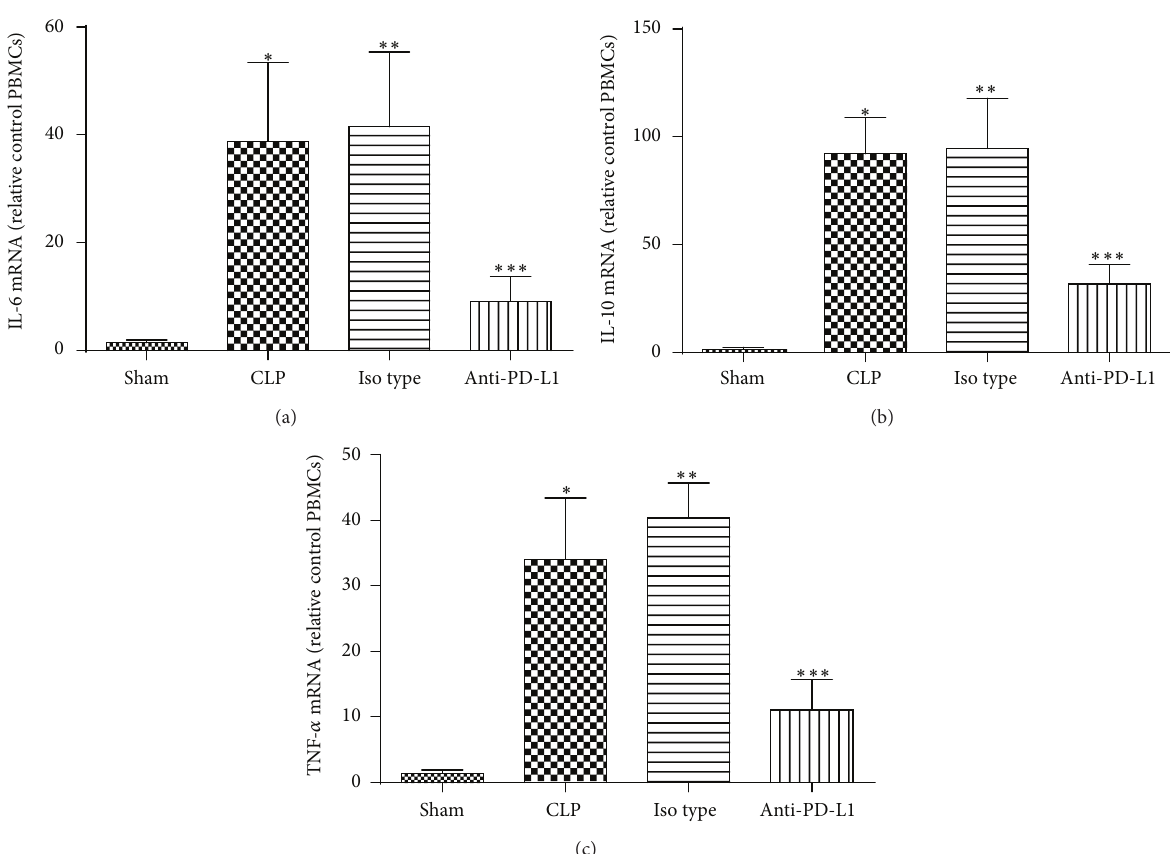
Figure 6: Anti-PD-L1 antibody altered mRNA expression of IL-6, IL-10, and TNF- 𝛼 in the liver of septic mice. Mice were administered anti-PD-L1 antibody (50 𝜇 g, i.p.). Liver specimens were sampled 24 hours after surgery. ∗ 𝑃 < 0.01 versus Sham, ∗∗∗ 𝑃 < 0.01 versus CLP, ∗∗ 𝑃 = 0.7128 (IL-6), 𝑃 = 0.8133 (IL-10), and 𝑃 = 0.1228 (TNF- 𝛼 ) versus CLP. Bars represent the mean ± SD of eight mice for each